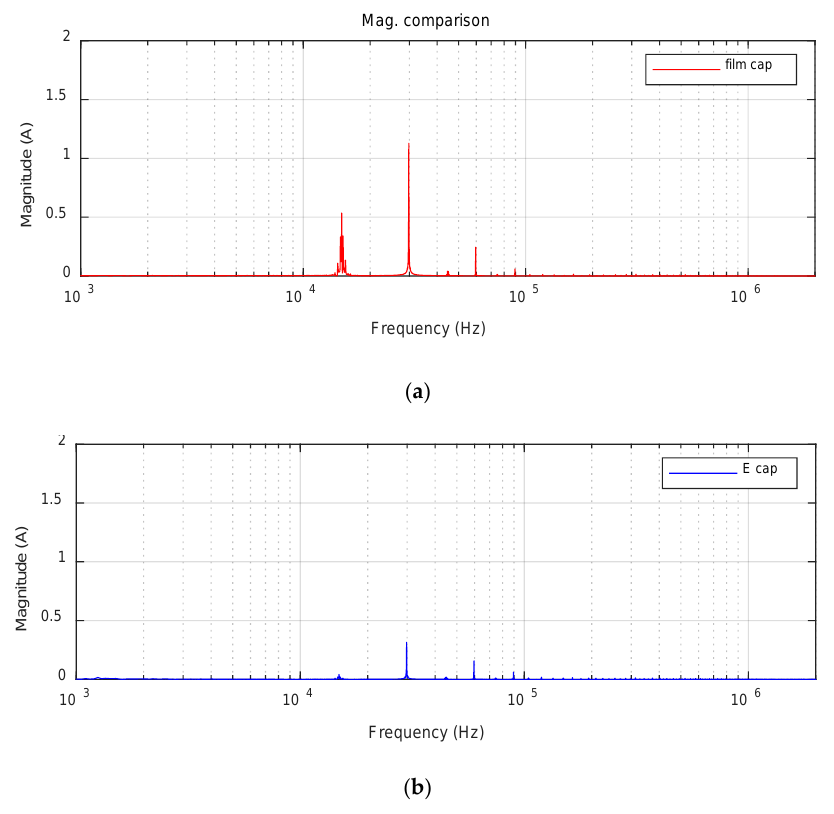
Figure 13. Magnitude of DC-link currents of VSI with film ( a ) and electrolytic ( b ) capacitors as functions of frequency. At motor speed = 1000 rpm and phase current amplitude = 20 A.